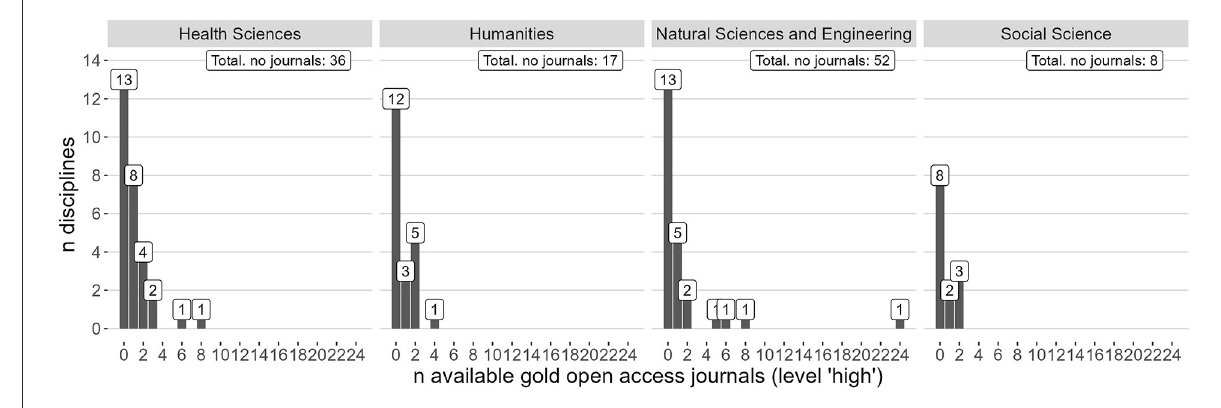
FIGURE10 Shares of gold open access articles on the normal level for two groups of disciplines. Blue line represents gold publishing on level normal by disciplines with the option of gold open access journals on the high level, disciplines without this option is represented by the red line. For reference, the grey line represents the share of all gold articles on level normal regardless of the group. The plot is separated on the four main research areas.